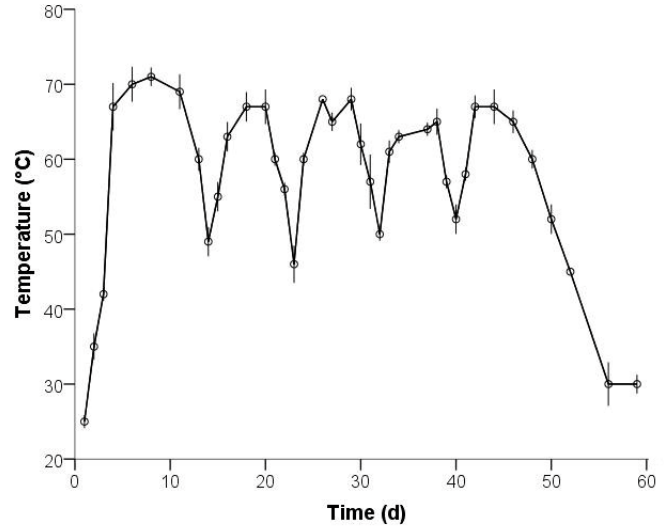
Figure 1. Temperature variance during OMW bioremediation. Error bars were placed at the 95% confidence level.